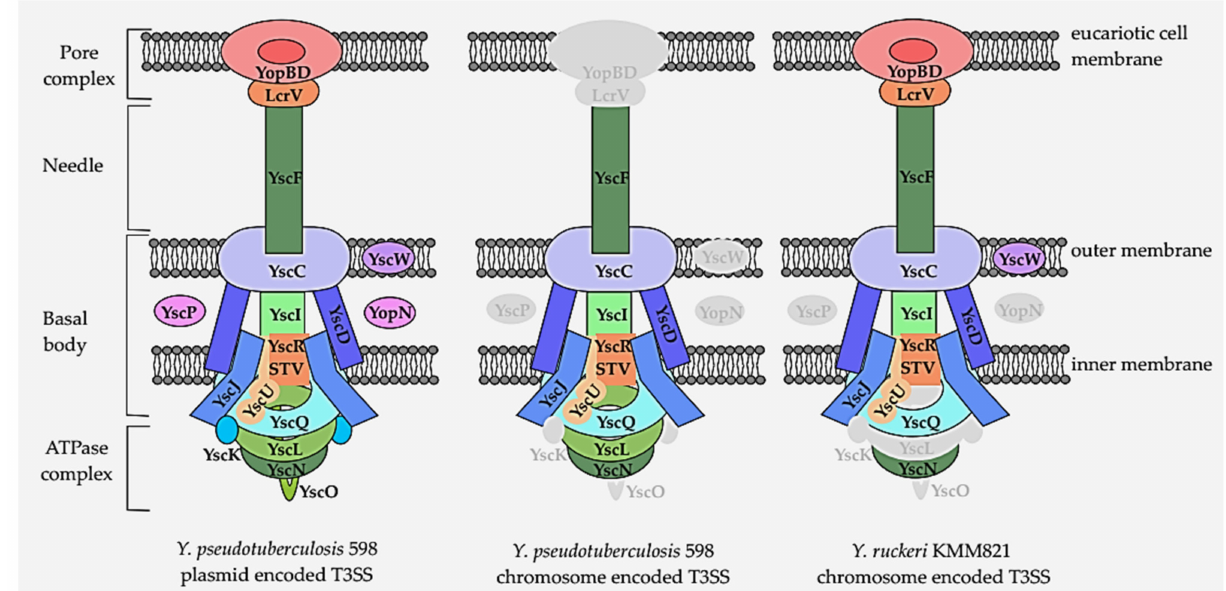
Figure 3. Comparison of key structural elements of the type III secretion system encoded by the chromosome of Y. ruckeri KMM821 and the chromosome and plasmid of Y. pseudotuberculosis 598. Gray indicates the missing parts of T3SS. Basal body: YscC—secretin, outer membrane ring; YscW— secretin pilotin, required for the proper localization of the secretin YscC in the outer membrane; YscD— inner membrane ring; YscJ—inner membrane ring; YscF—needle; YscI—inner rod. Export apparatus: YscU—autoprotease; YscV—export gate; YscR—inner membrane component; YscS—inner membrane component; YscT—inner membrane component. Cytoplasmic ring: YscQ. ATPase complex: YscN– ATPase; YscL–stator; YscO–stalk; YscK–ATPase cofactor. Regulators: YscP—needle-length regulator; YopN—switch regulator. Translocators: YopD—translocation pore; YopB—translocation pore;